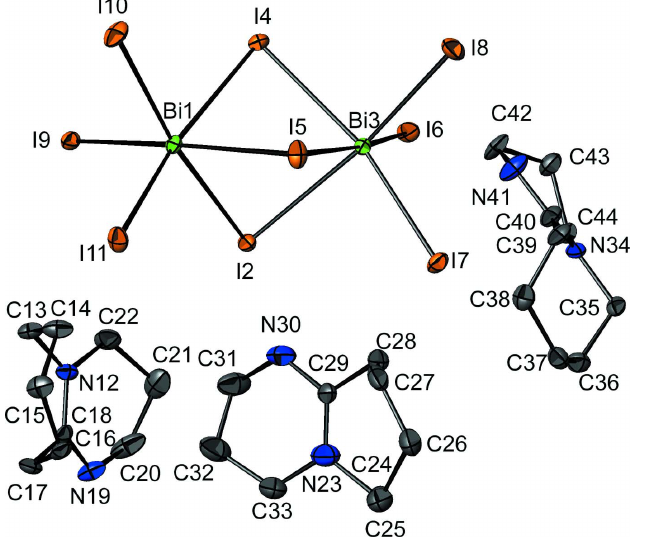
Figure 1 The asymmetric unit of (C 9 H 7 N 2 ) 3 Bi 2 I 9 with displacement ellipsoids drawn at the 50% probability level. H atoms have been omitted for clarity. Only one orientation of the disordered DBUH + ring is shown.